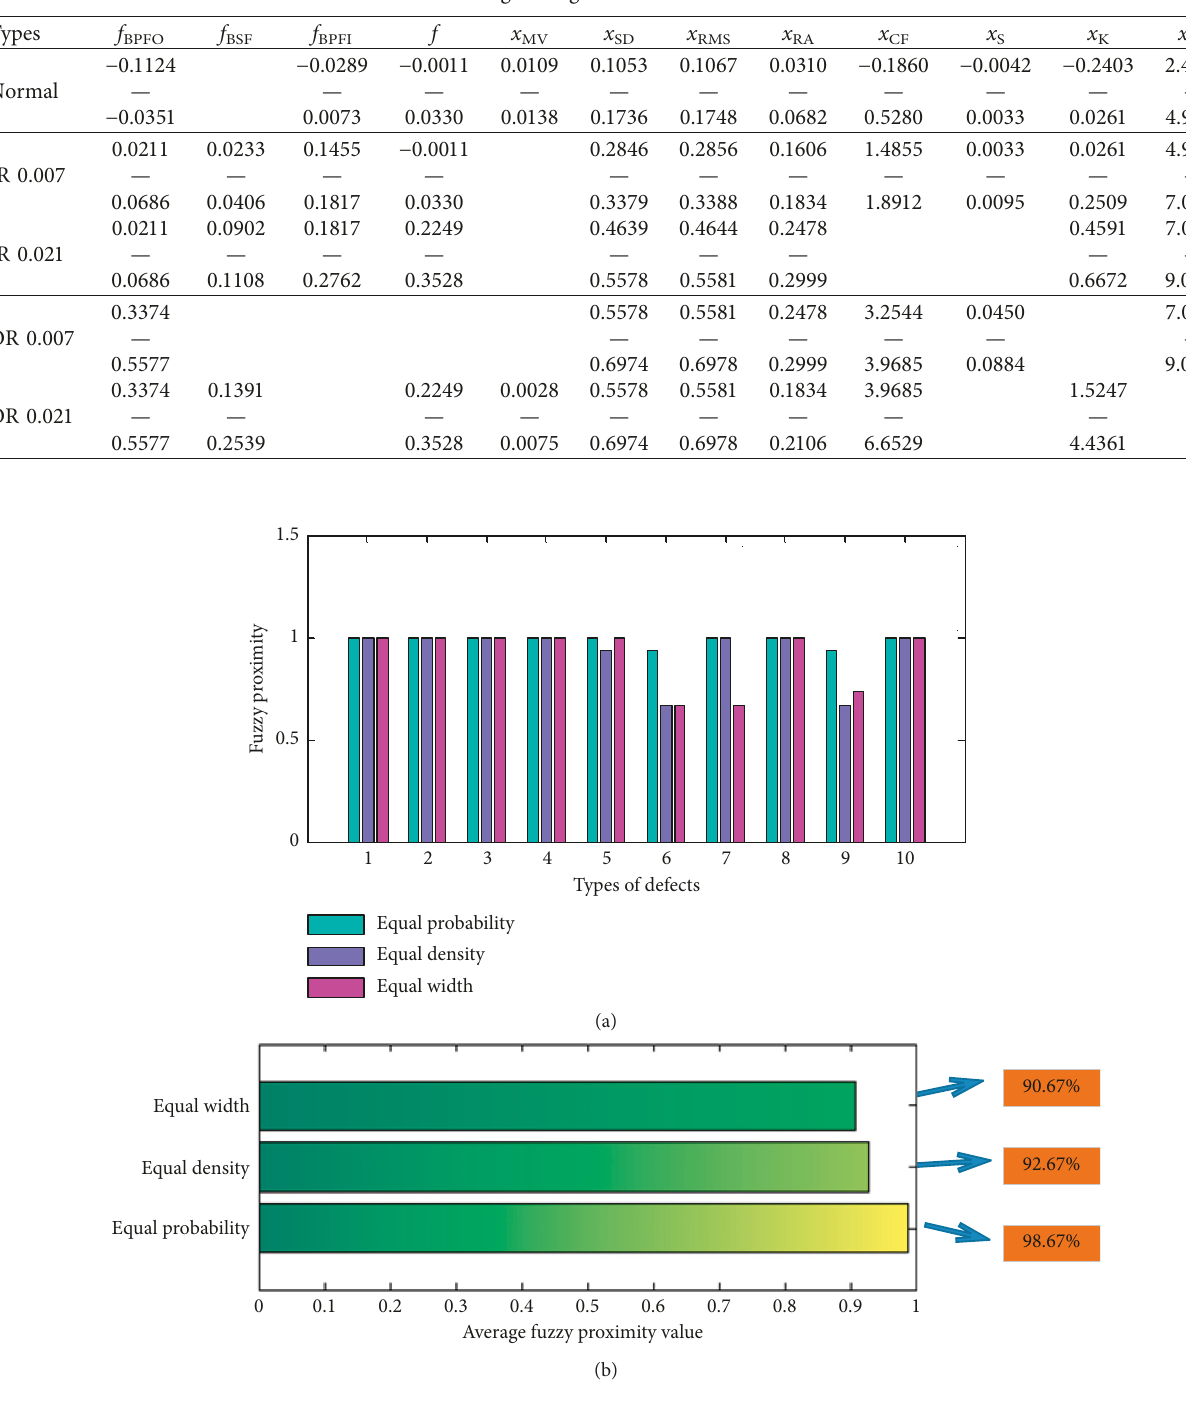
Figure 7: The classification accuracies of defect types using fuzzy proximity method. (a) The classification accuracy of each type of bearing defect and (b) the average accuracy of 10 types of bearing